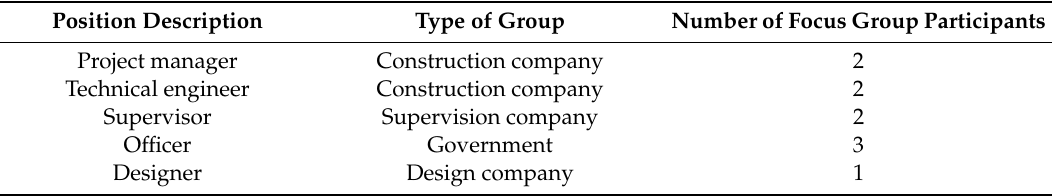
Table 4. Position and number of focus group participants.